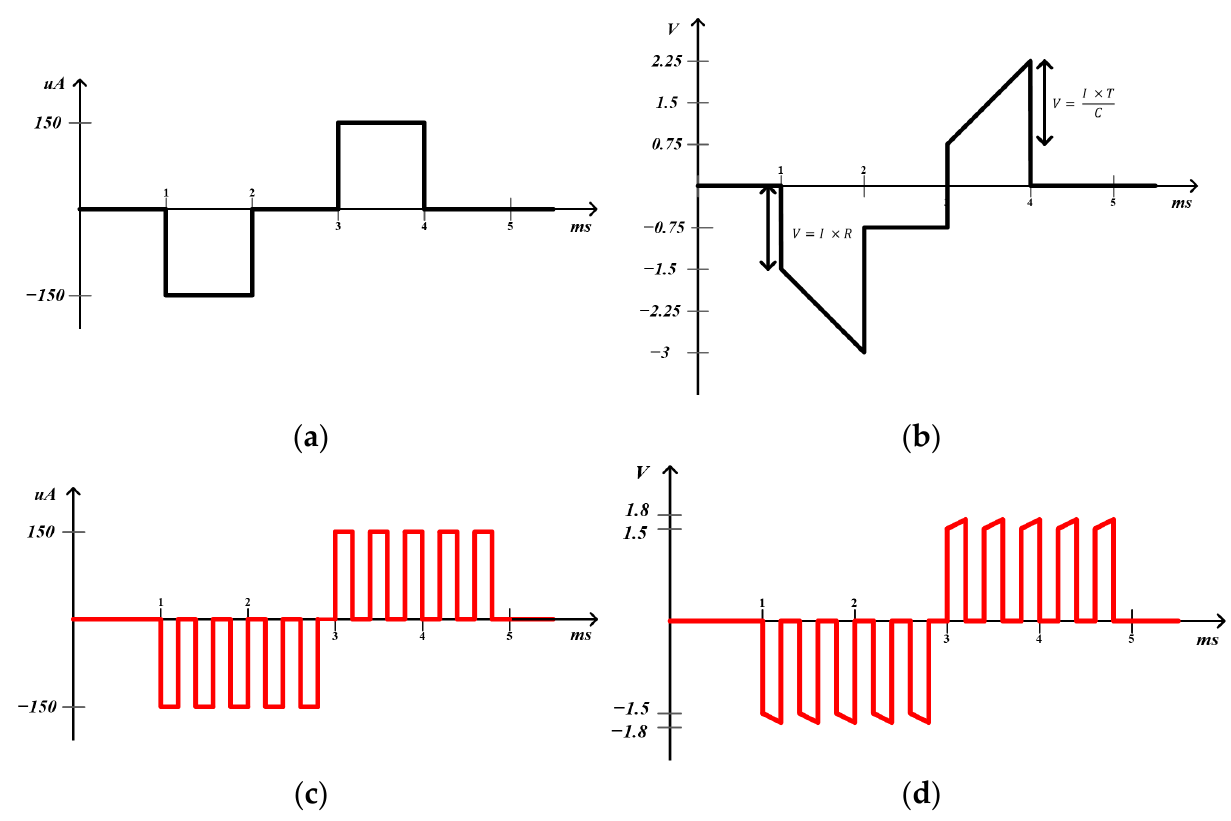
Figure 2. Examples of current–time and voltage–time graphs to compare conventional biphasic stimulation with proposed biphasic stimulation. ( a ) Current–time graph of single biphasic pulse for 150 nC ( i = 150 μ A, t = 1 ms) ( b ) Voltage–time graph of single biphasic pulse. Depending on the typical electrode model value [16], C is set at 100 nF and R is set at 10 K Ω . Furthermore, 1.5 V voltage is defined by Ohm’s law (V = I × R). Compliance voltage is 1.5 V, which can be obtained from equation 𝑄 = 𝑖 × 𝑡 = 𝐶 × 𝑉. 𝑉 can be defined as 𝑖 × 𝑡 / 𝐶 . ( c ) Current–time graph of pro- posed biphasic pulse for 150 nC (five pulses with I = 150 μ A, t = 200 μ s) ( d ) Voltage–time graph with a reduced compliance voltage using proposed biphasic pulses. Compliance voltage is 0.3 V, which is a result of decrease in the charge injection duration time.